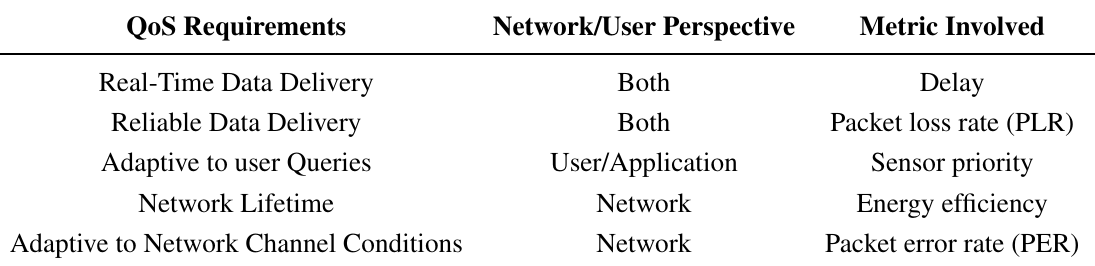
Table 3. QoS requirements for WBSNs from network and user